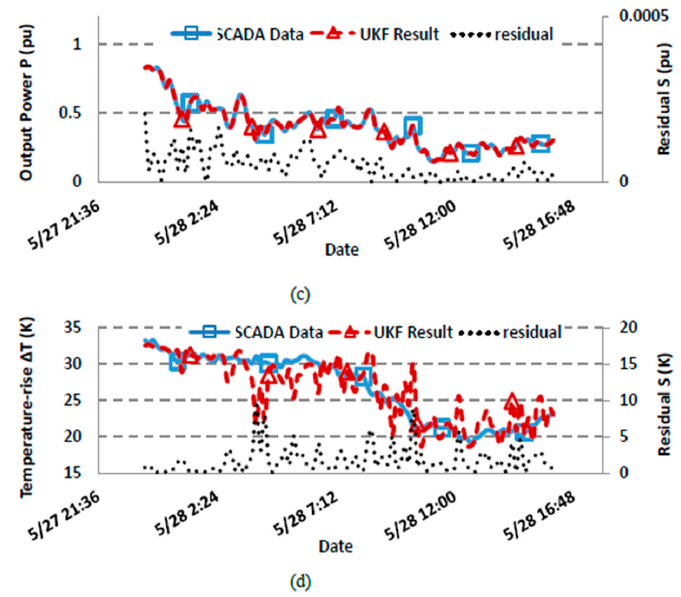
Figure 10. Comparison of UKF prediction and SCADA data in health, 2006. ( a ) Wind speed; ( b ) Rotor speed; ( c ) Output power; ( d ) Temperature rise.